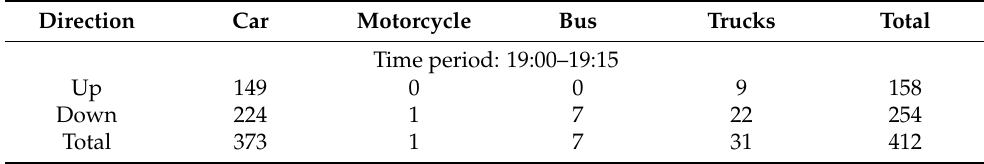
Table 2. Results obtained from camera count during the day.